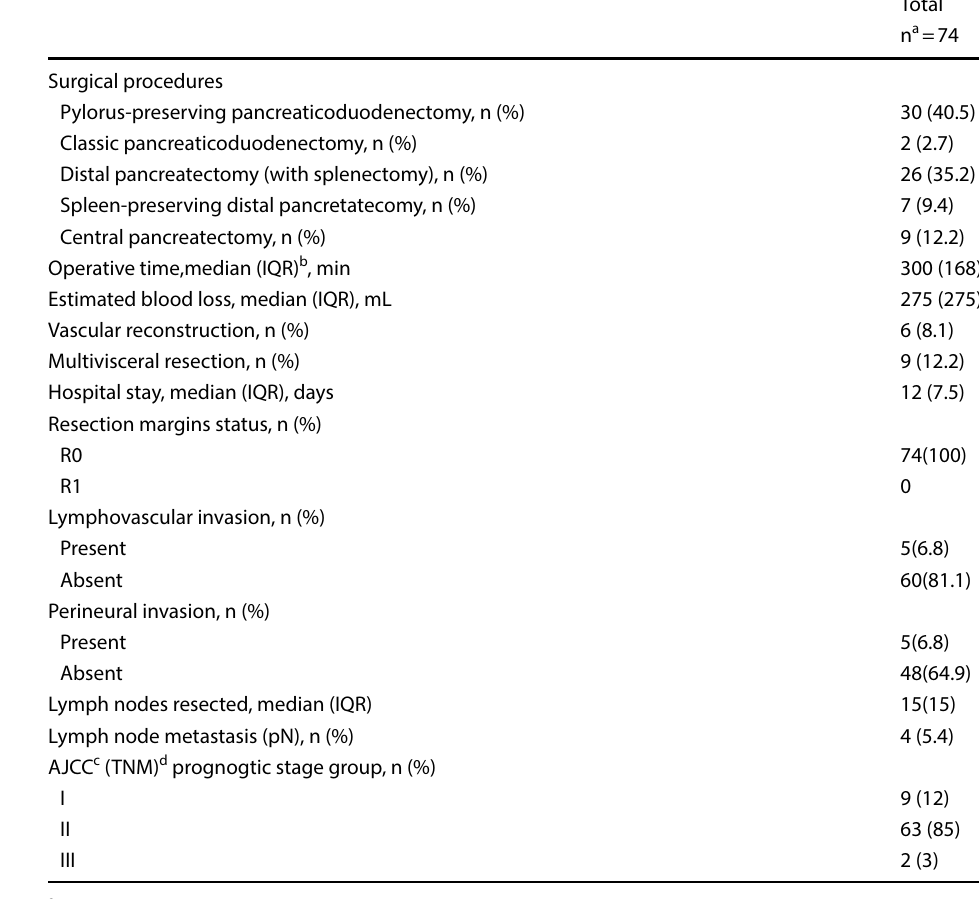
Table 2 Surgical and pathological characteristics in 74 patients with solid pseudopapillary neoplasm who underwent